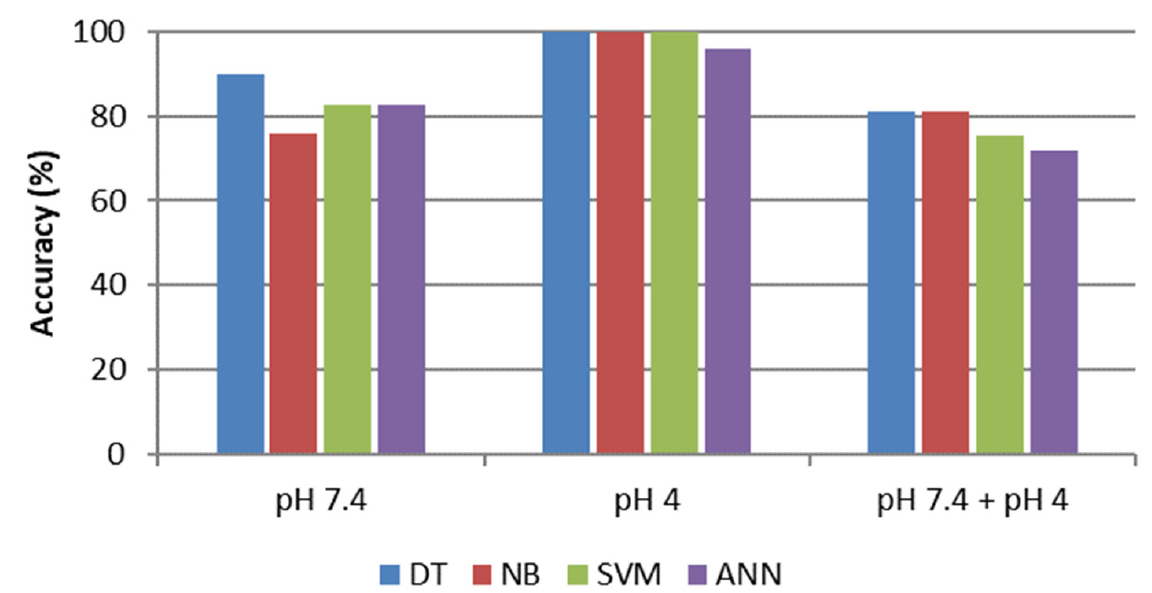
Figure 8. Testing classification accuracy for copper ion discrimination in F12 at different pH condi- tions.